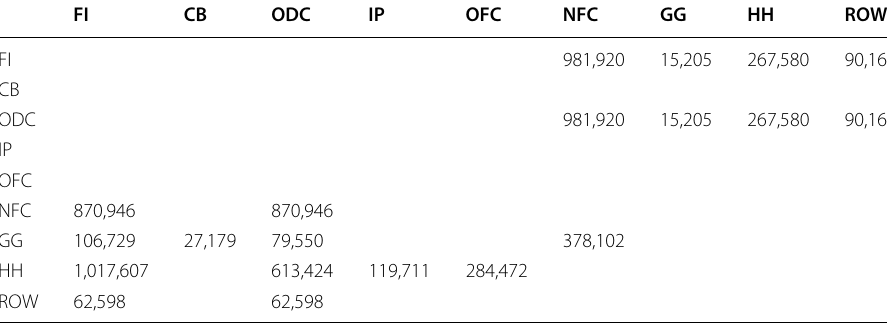
Table 12 Financial Asset/Liability Stocks for which Counterpart Sectors can be Identified (in units of 100 million CNY)